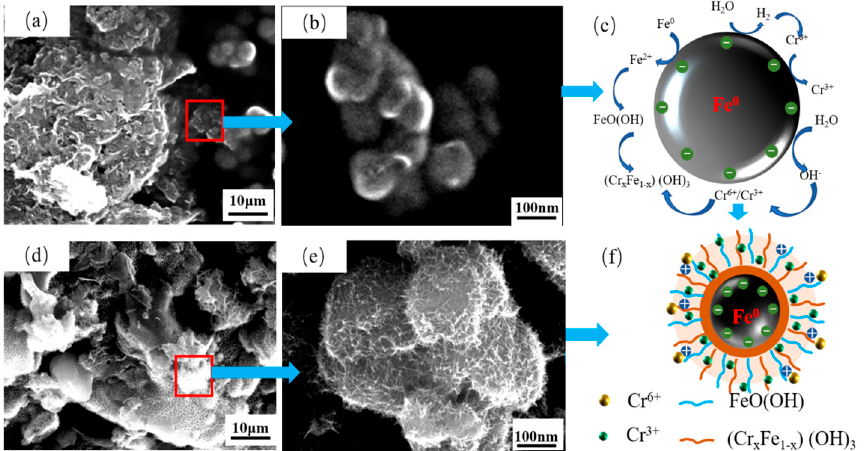
Figure 6. Mechanism for the reduction–adsorption of Cr by BC-nZVI. ( a , b ) SEM micrographs of BC-nZVI before reaction, ( c , f ) mechanism for the reduction–adsorption of Cr by nZVI, and ( d , e ) SEM micrographs of BC-nZVI after reaction.